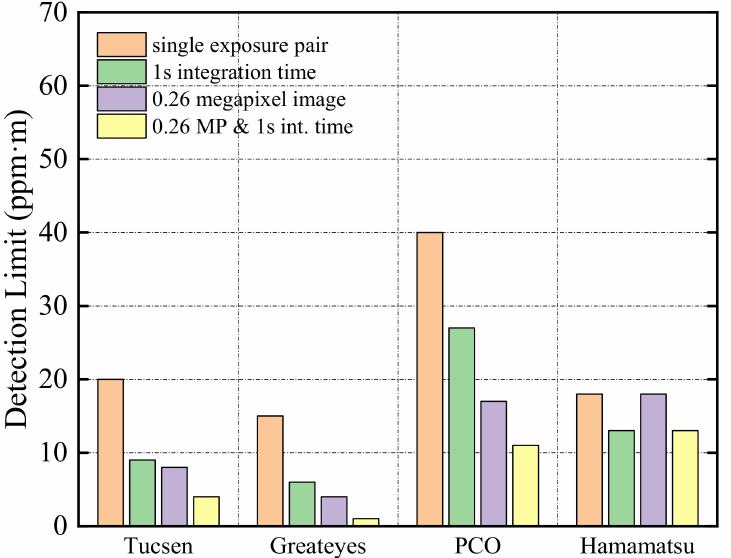
Figure 13. Detection limits of different camera systems with a detection distance of 2 km and atmospheric visibility of 50